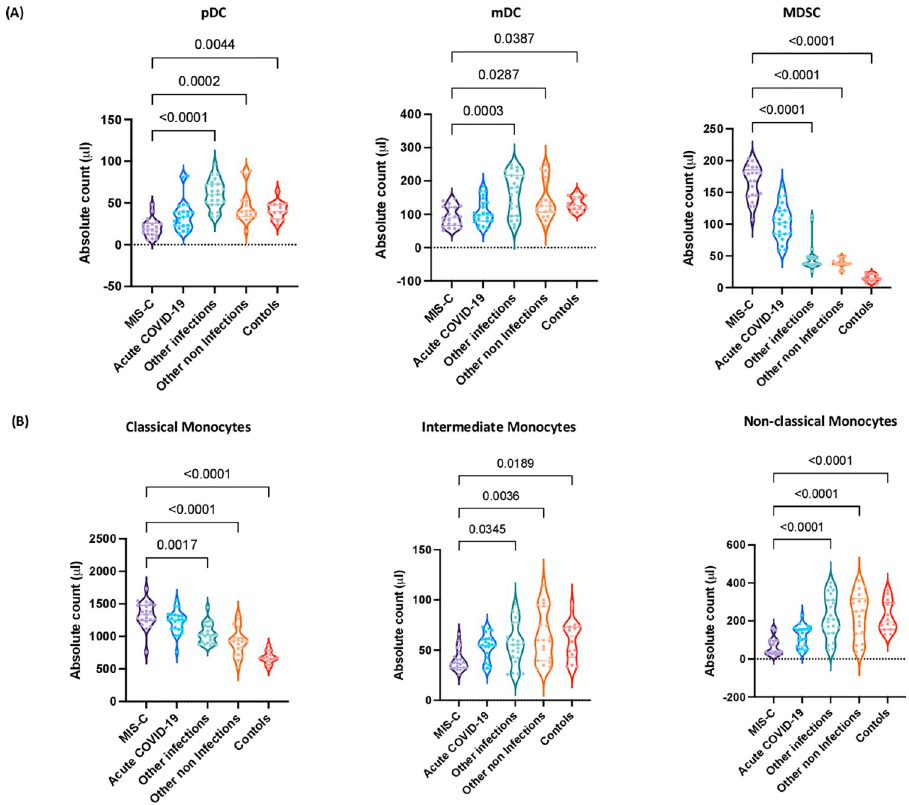
Fig 3. Altered numbers of DC and monocyte subsets are associated with MIS-C. Title. (A) Absolute numbers of DC subsets in MIS-C (n = 21), acute COVID-19 (n = 23), other infectious (n = 23), other non-infectious diseases (n = 21) and controls (n = 14). The data are represented as scatter violin plots with each circle representing a single individual. p values were calculated using the Kruskal-Wallis test with Dunn’s post-hoc for multiple comparisons. (B) Absolute numbers of monocyte subsets in MIS-C (n = 21), acute COVID-19 (n = 23), other infectious (n = 23), other non- infectious diseases (n = 21) and controls (n = 14). The data are represented as scatter violin plots with each circle representing a single individual. p values were calculated using the Kruskal-Wallis test with Dunn’s post-hoc for multiple comparisons.